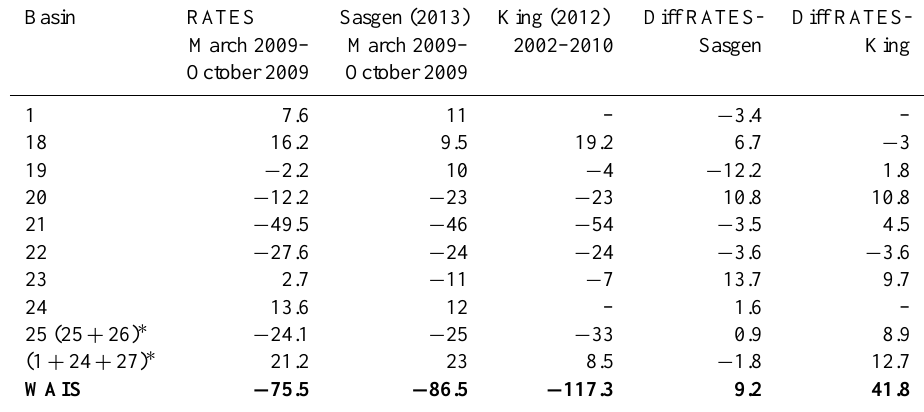
Figure 6. (a) GIA estimate with GPS stations and their rates. Stippled points denote areas in which the mean signal is larger than the marginal standard deviation. (b) GIA error estimate (1 standard deviation). Table 3. Ice and SMB mass trends from RATES, Sasgen et al. (2013), and King et al. (2012) inGtyr. ∗ Our basin 25 is equal to the sum of basins 25 and 26 in King et al. (2012). The sum of our basins 1 and 24 is equal to their sum of basins 1, 24, and 27. Basin